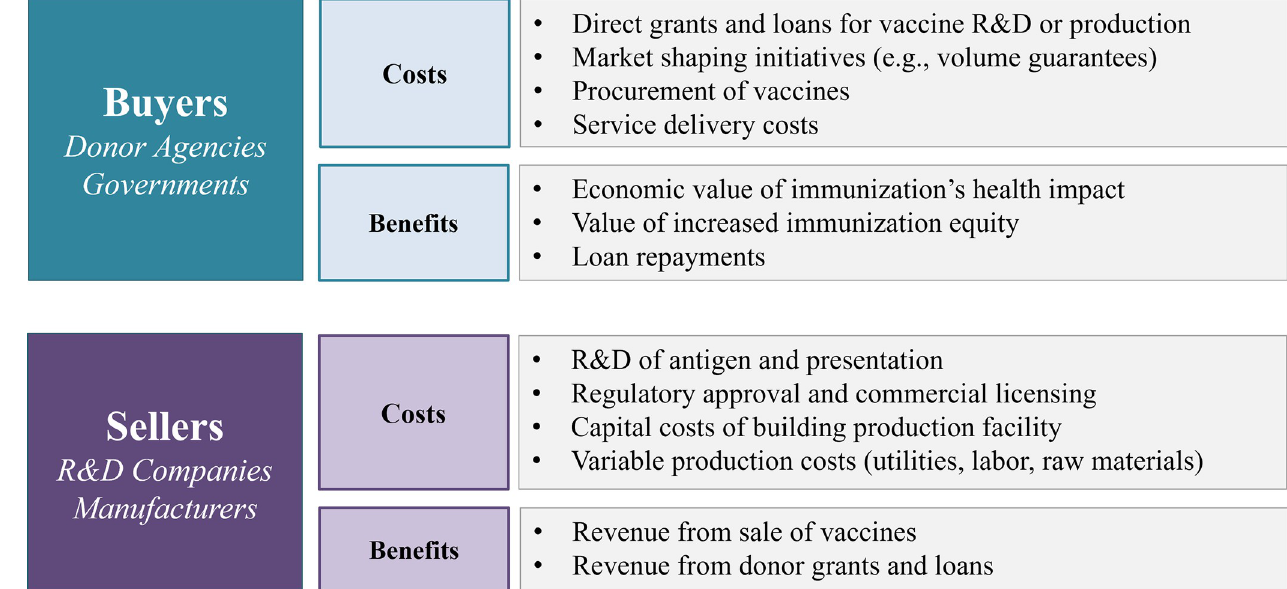
Fig 2. Summary of key costs and benefits for vaccine buyers and